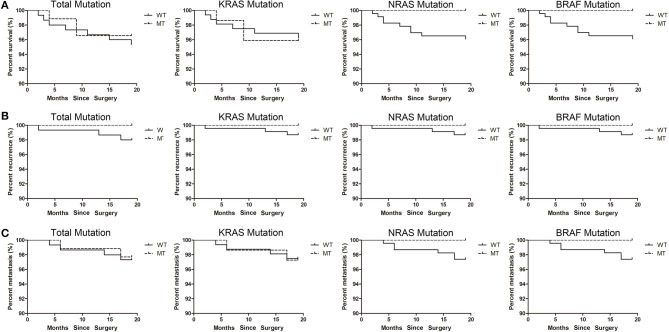
The correspondence between mutations and prognosis. (A) The correspondence between mutations and survival. (B) The correspondence between mutations and recurrence. (C) The correspondence between mutations and metastasis.